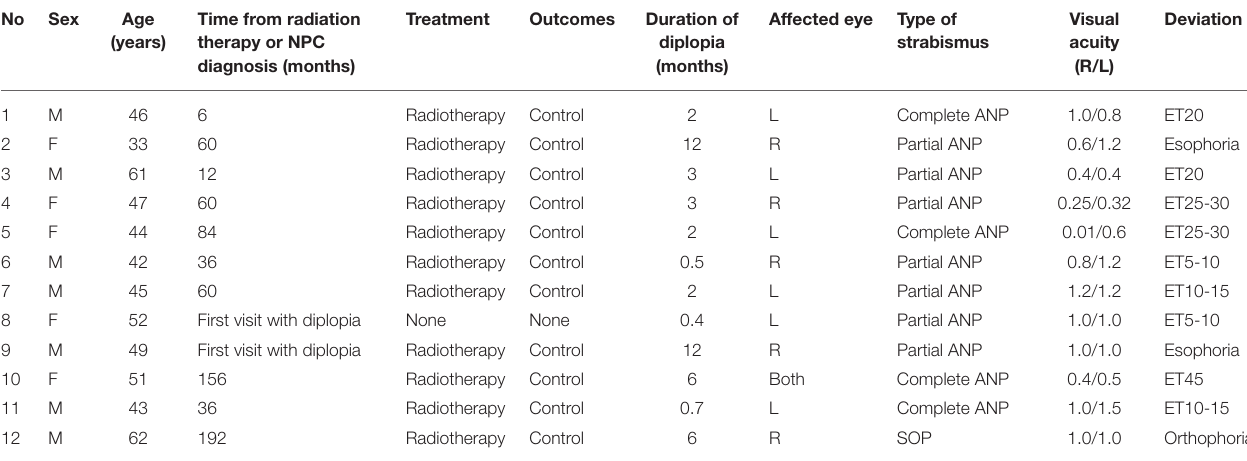
TABLE 3 | Characteristics of individual patients with nasopharyngeal carcinoma associated diplopia. No